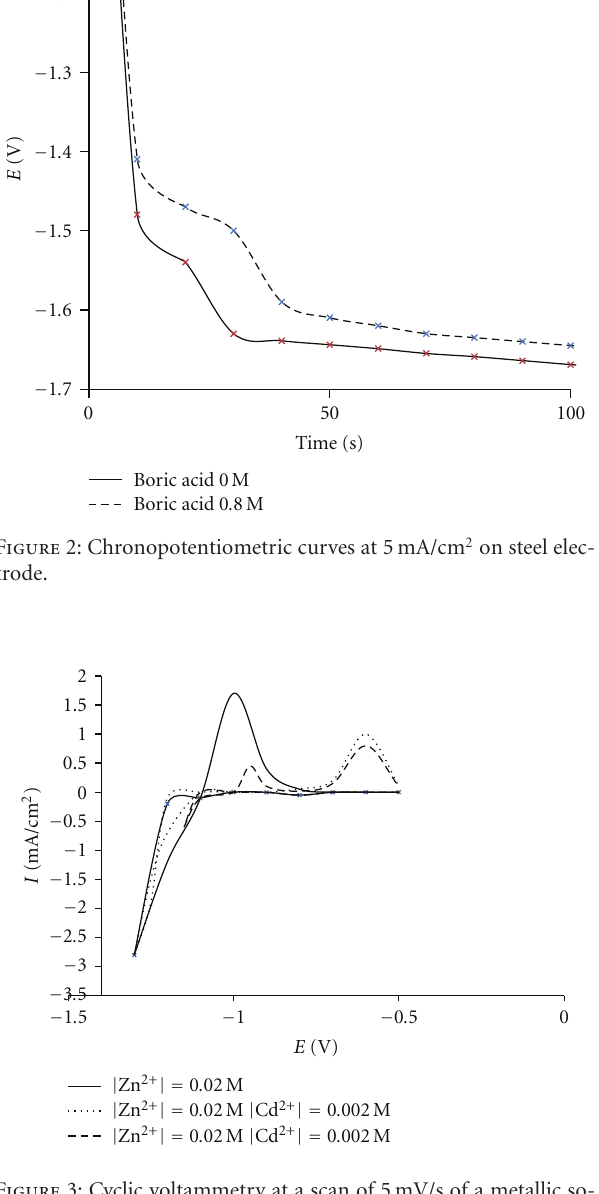
Figure 3: Cyclic voltammetry at a scan of 5mV/s of a metallic so- lution containing | Na 2 SO 4 | = 0.5M at pH = 3.5.